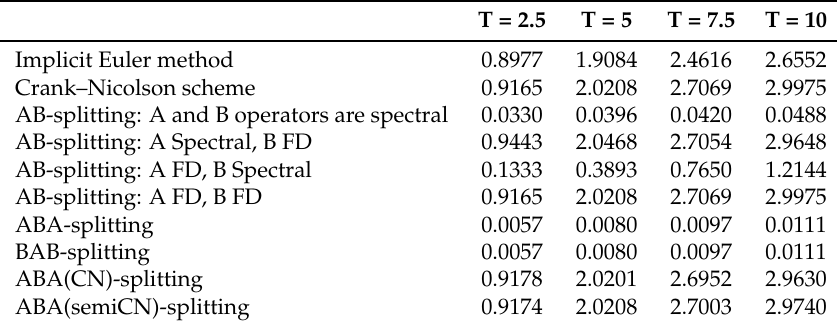
Table 4. Numerical errors of one soliton with the different methods.